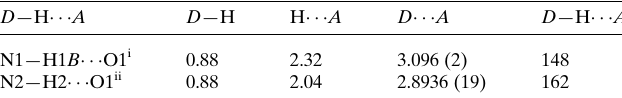
Table 1 Hydrogen-bond geometry (A˚ , (cid:3) ).